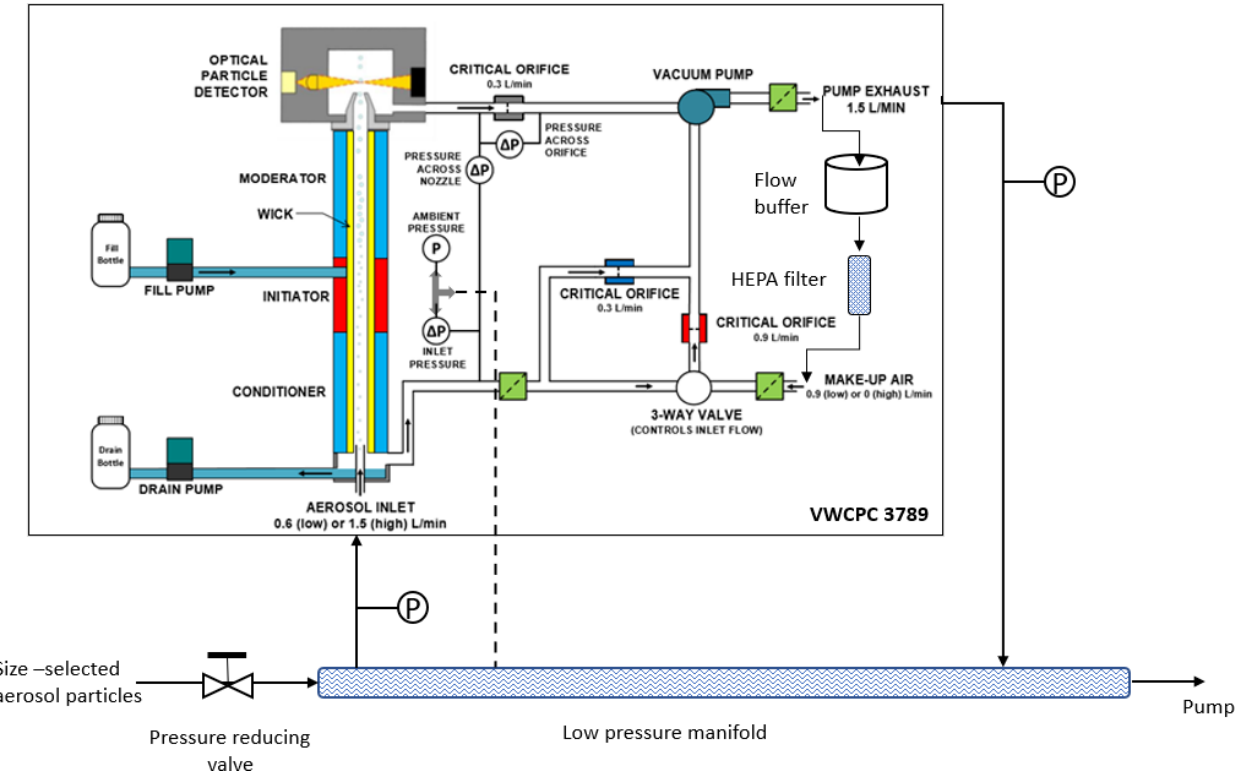
Figure 1. Schematic of the modified vWCPC 3789 sensors and flow system (TSI Incorporated, 2019).